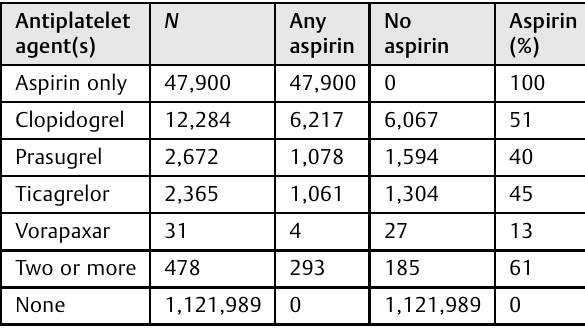
Table 1 Overall annual (2015) distribution of OAA regimens